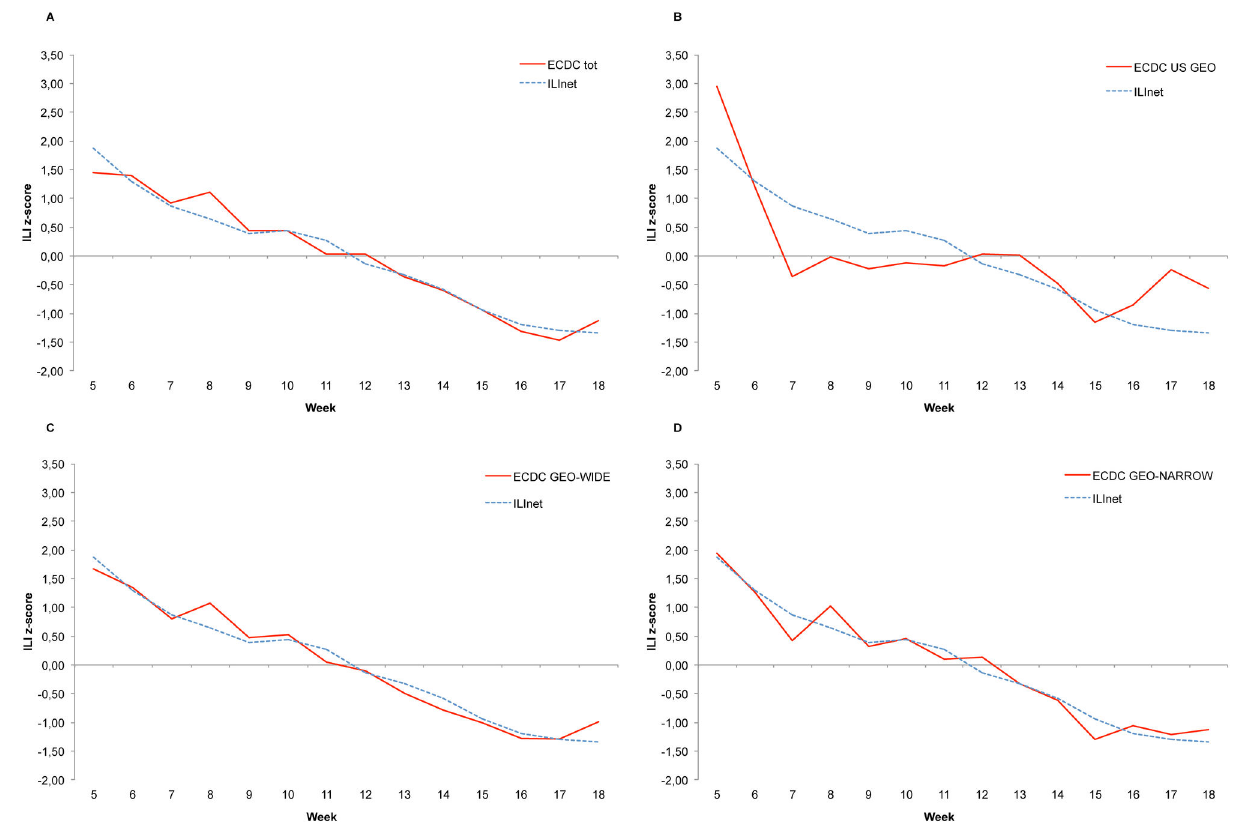
Figure 2. Weekly reported ILI (CDC) and tweets satisfying ILI query. The blue line represents in all graphs the z-scores of CDC’s reported ILI for the 14-week period starting in week 5 (January 2013) through week 18 (May 2013). The red line represents the z-scores of tweets satisfying the ECDC ILI query, selected with a different geolocalization strategy in each of the four graphs: a) all tweets (independently from geolocalization); b) US GEO(GPS localized tweets); c) Extended wide localization pattern; d) Extended narrow localization